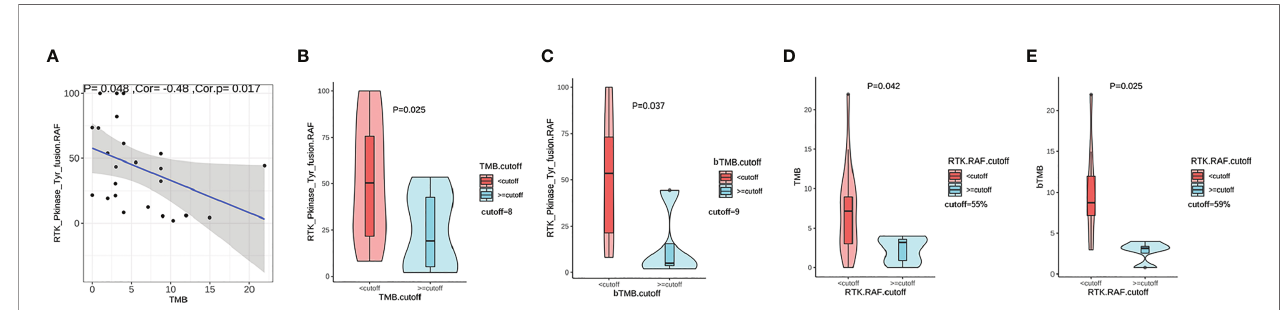
FIGURE 3 | The correlation between TMB and relative RTK fusion allele frequency (RTK. RAF). (A) Pearson correlation between TMB and RTK. RAF (fusion AF/max AF) (n=24); (B) Comparison of RTK. RAF in TMB-high vs. TMB-low groups (n=24). (C) Comparison of RTK. RAF in blood TMB-high vs. blood TMB-low groups (n=13). (D) Comparison of the TMB in RTK. RAF -high vs. RTK. RAF -low groups (n=24). (E) Comparison of the blood TMB in RTK. RAF -high vs. RTK. RAF -low groups (n=13).